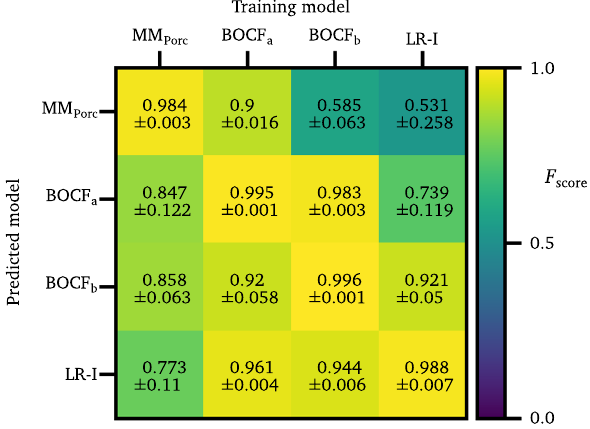
Figure 5. The F score is shown for all combinations of training models, and prediction models.